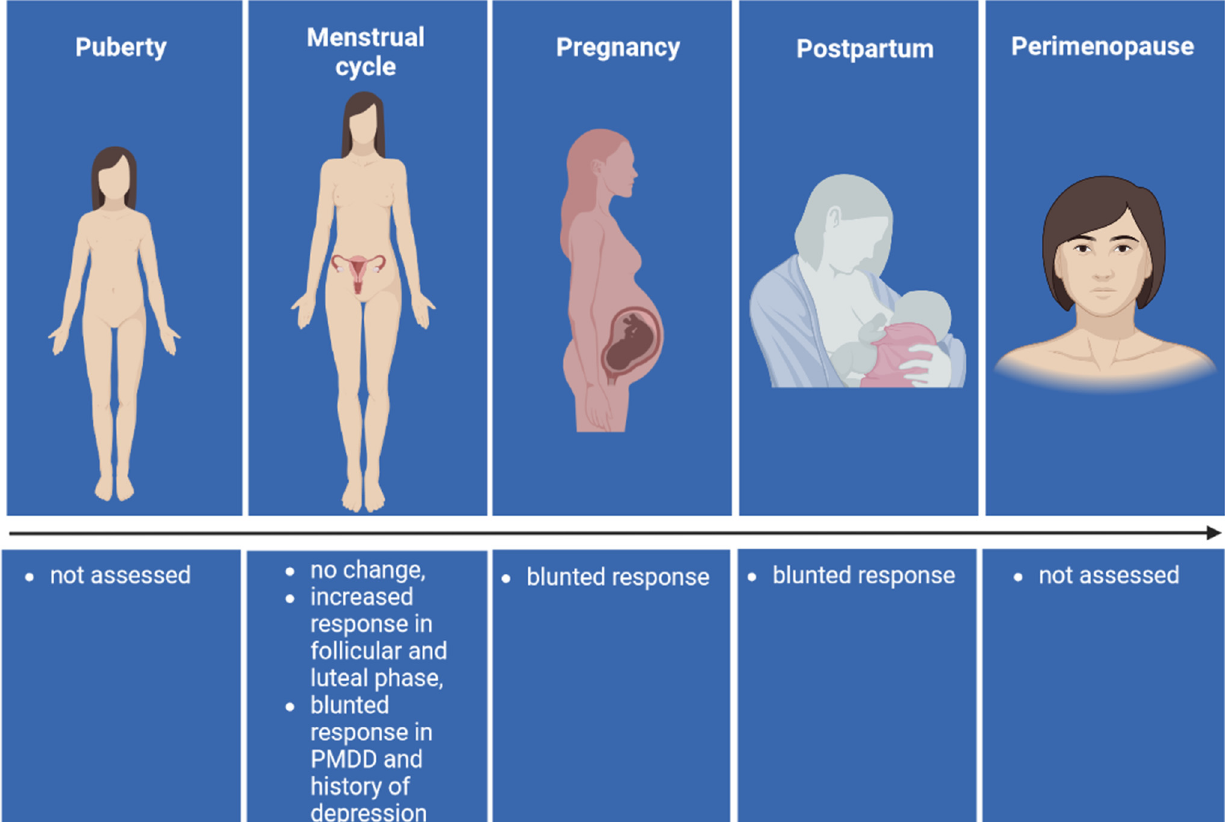
Figure 1. Schematic representation of the allopregnanolone response to acute stress under different conditions that characterize the female lifespan. Figure created using BioRender.com accessed on 27 July 2022.